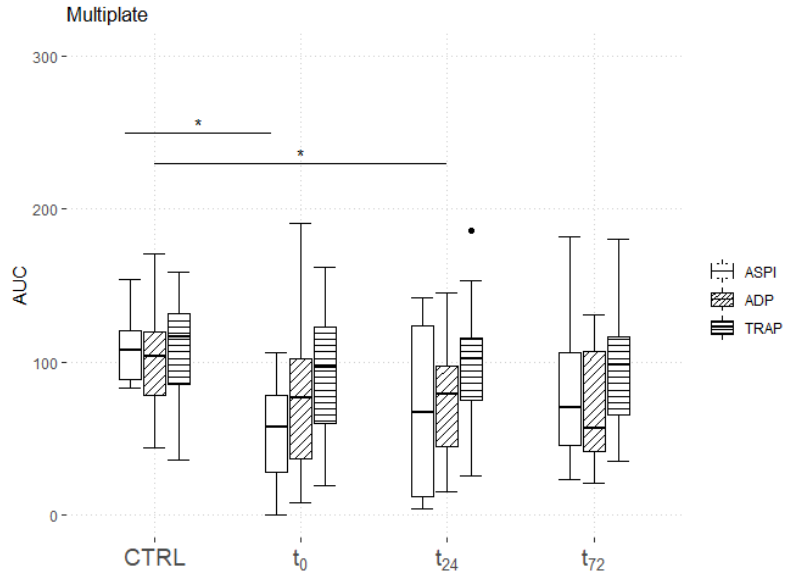
Figure 2. Time course of impedance platelet aggregometry. Patients with COVID-19 presented significantly unsatisfactory AUCs for the ASPI level at t 0 and the ADP level at t 24 . No significant differences in the TRAP level were found. Asterisks display the degree of statistical significance: *: p ≤ 0.05. Abbreviations: ADP = adenosine diphosphate; ASPI = arachidonic acid; AUC = area under the curve; CTRL = control group; TRAP = thrombin receptor-activating